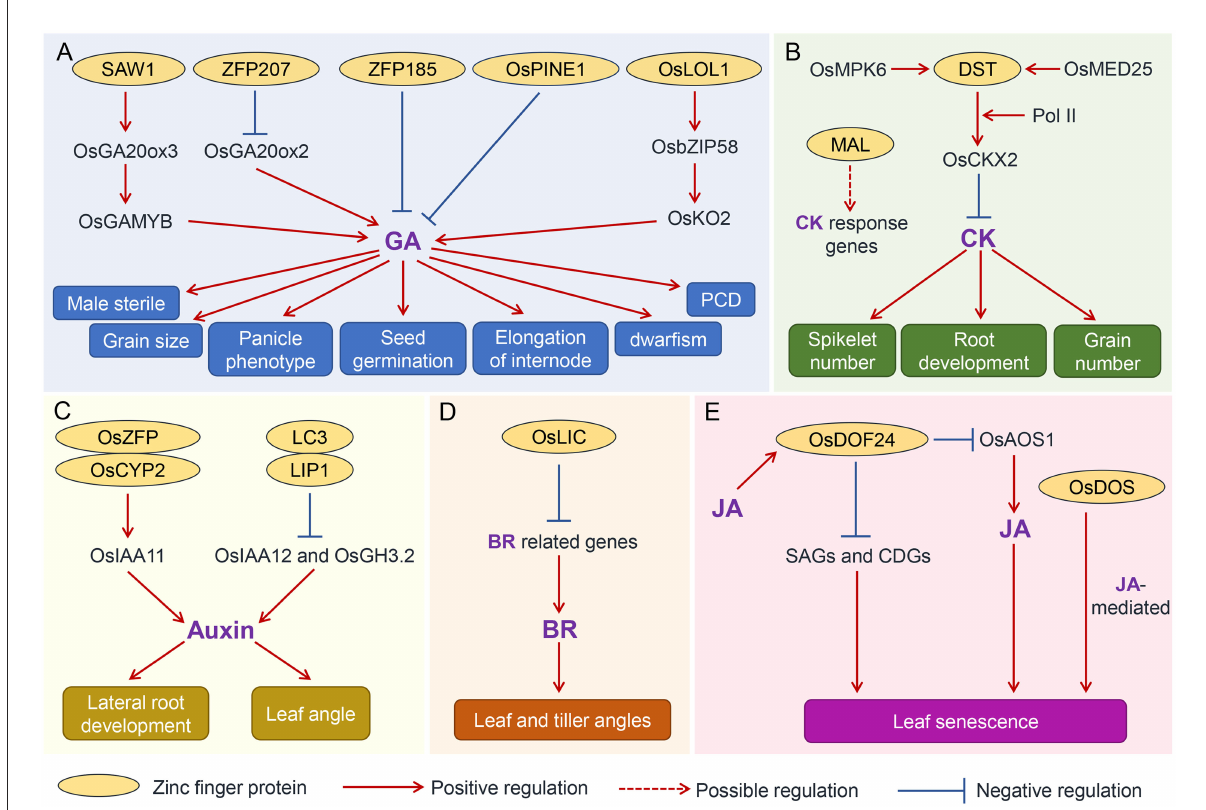
FIGURE3 The proposed regulatory network of zinc finger proteins and phytohormones pathways in determining agronomic traits in rice. The regulatory network of zinc finger protein and GA (A) , CK (B) , auxin (C) , BR (D) , and JA (E) . Positive and negative regulations of various agronomic traits mediated by different zinc finger proteins are indicated by solid lines, and the proposed regulation of zinc finger proteins on downstream targets is indicated by the dashed line. The proteins with cycle are the zinc finger proteins. GA, gibberellins; CK, cytokinin; BR, brassinosteroid; JA, jasmonic acid. SAW1, Swollen Anther Wall 1; OsGA20ox3, GA biosynthetic gene; OsGAMYB, anther-regulator gene; OsGA20ox2, GA biosynthetic gene; OSPINE1, premature internode elongation 1; OSKO2, GA biosynthetic gene; DST, drought and salt tolerance; OsMED25, mediator subunit; OsCKX2, cytokinin oxidase 2; MAL, meristem activityless; LC3, leaf inclination 3; LIP1, LC3-interacting protein 1; OsLIC, tiller angle increased controller; OsDOF24, DNA-binding one zinc finger 24; CDGs chlorophyll degradation genes; SAGs,